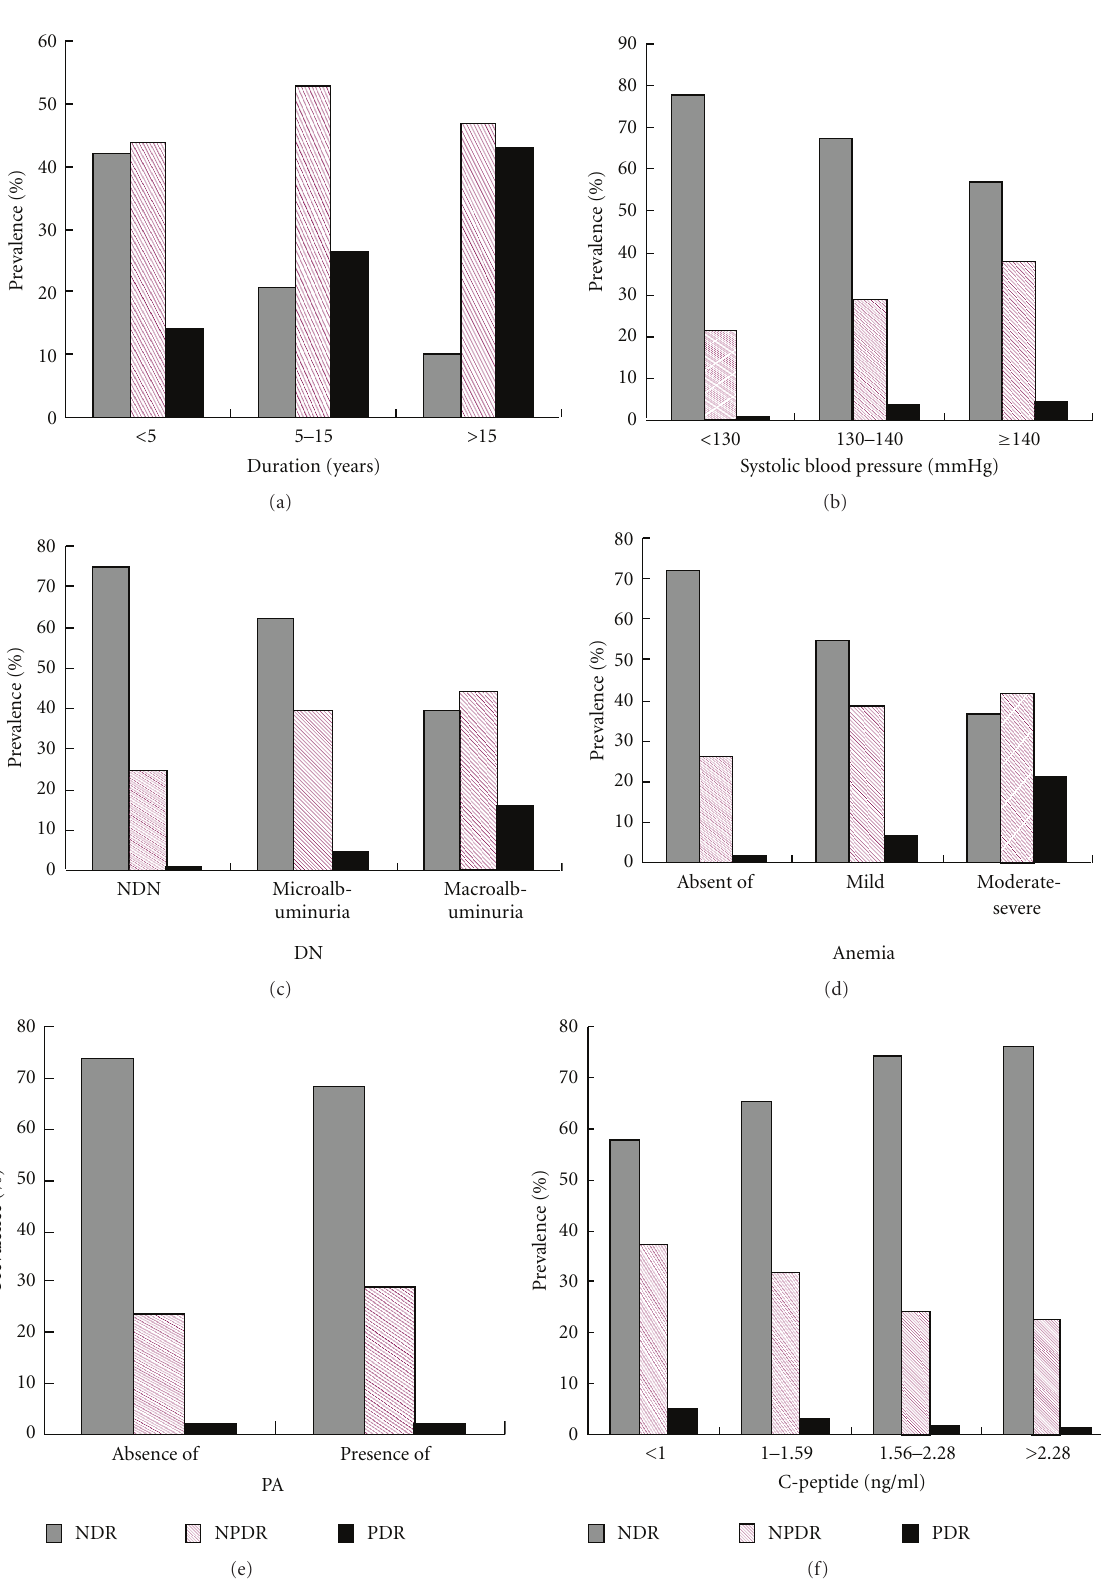
Figure 1: Prevalence of NDR, NPDR, and PDR for the related risk factors. All had P value < 0.01 by the trend